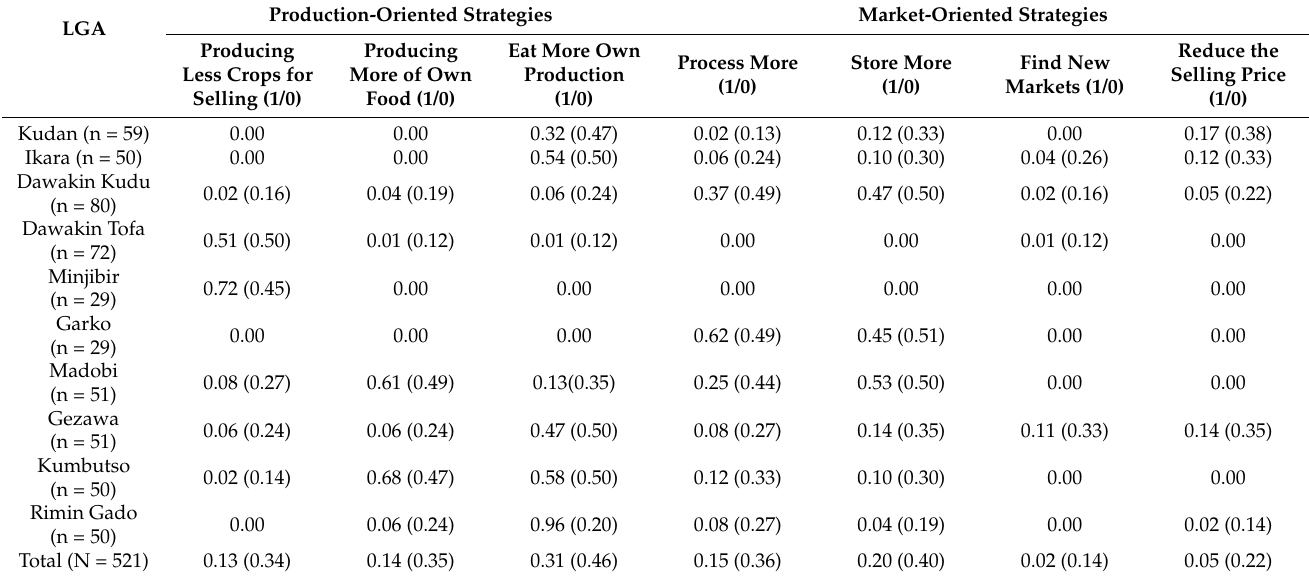
Table 7. Share of farm households using various coping strategies in vegetable production and marketing. Production-Oriented Strategies Market-Oriented